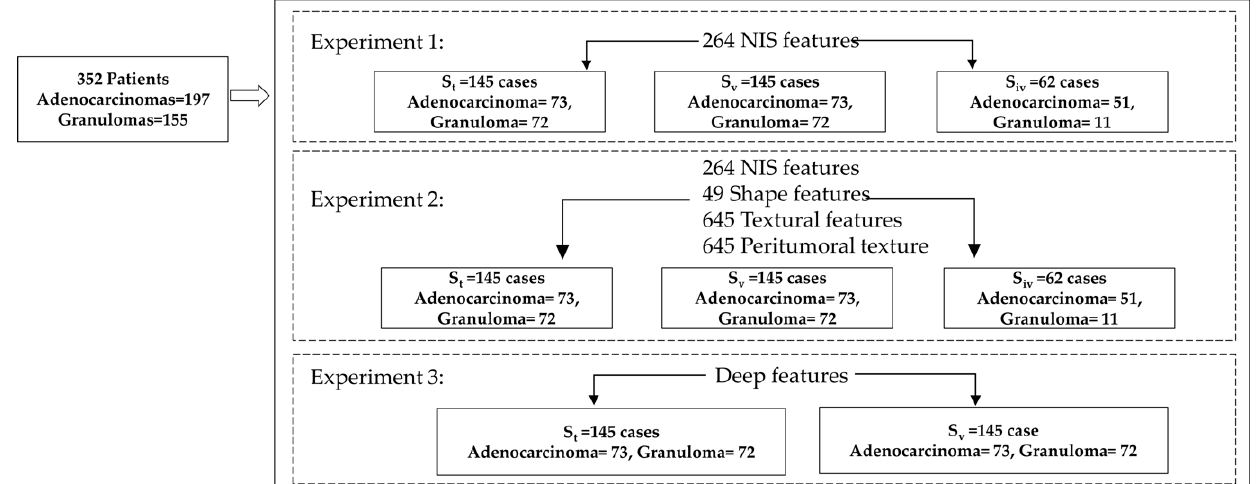
Figure 2. The dataset inclusion and experimental design of the study.